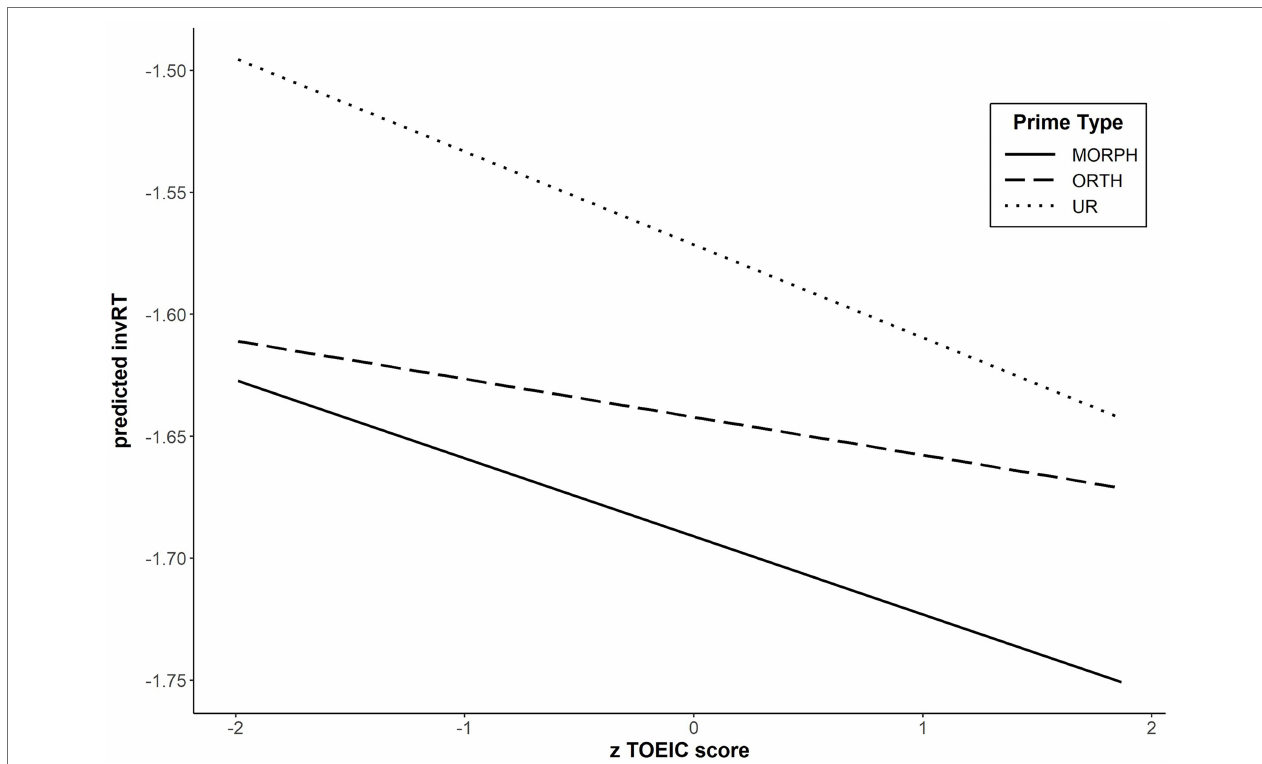
FIGURE 1 | Response latencies to L2 targets primed by morphological, orthographic, and unrelated primes and priming effects as a function of L2 proficiency in Experiment 2. Greater zTOEIC score indicates higher proficiency, and smaller invRT indicates faster responses to L2